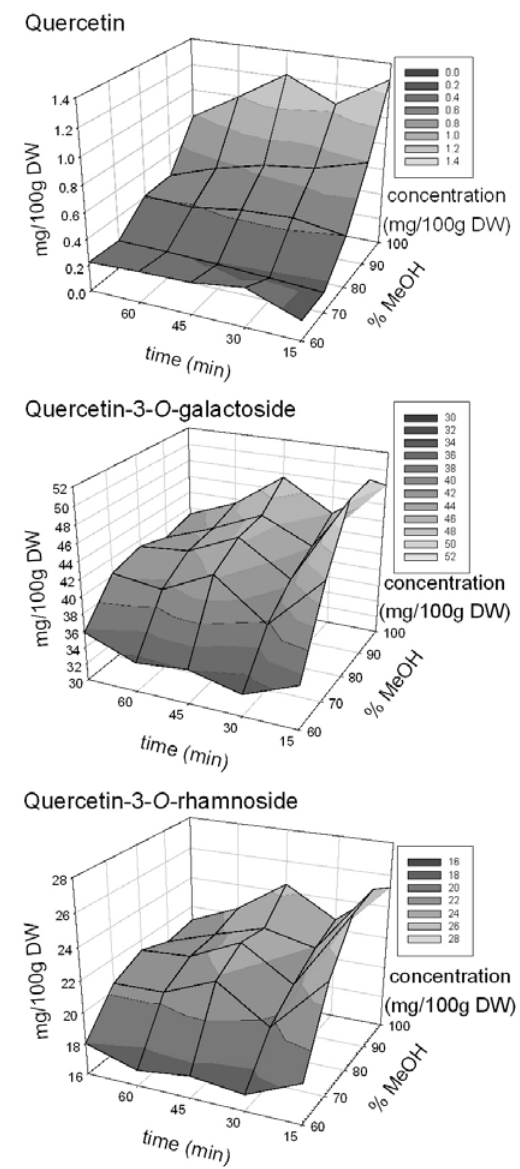
Figure 1. Response surface plots indicating the extraction of flavonols (mg/100 g DW) using various concentrations of methanol (%) at different ultrasonic bath times (min).